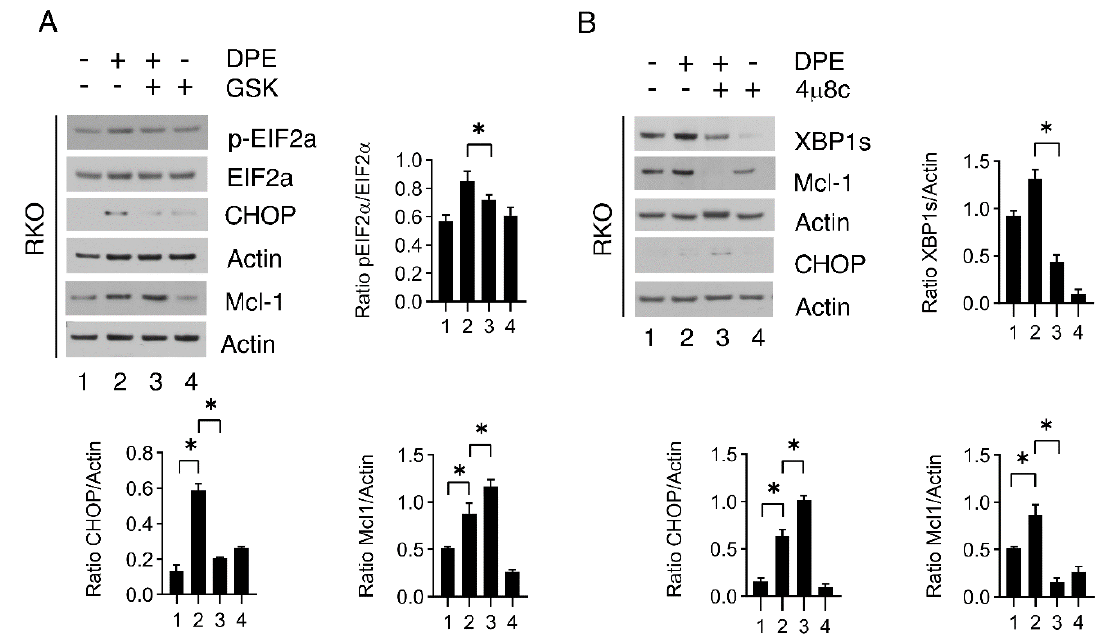
Figure 6. Inhibition of PERK or IRE1alpha influences the expression of CHOP and Mcl-1. ( A ) RKO was pre-treated with GSK (0.5 μ M) and then treated with DPE (50 μ M) or left untreated as control. After 48 h, the expression levels of p-EIF2 α , EIF2 α , CHOP, and Mcl-1 were evaluated by Western blot analysis. β -Actin was used as the loading control. The histograms represent the means plus S.D. from the densitometric analysis of the ratio between the protein and the appropriate control. ( B ) RKO was pre-treated with 4 μ 8C (10 μ M) and then treated with DPE (50 μ M) or left untreated as control. After 48 h, the expression levels of XBP1s, CHOP, and Mcl-1 were evaluated via Western blot analysis. β -Actin was used as the loading control. The histograms represent the means plus S.D. from the densitometric analysis of the ratio between the protein and β -actin. Note: * p < 0.05.